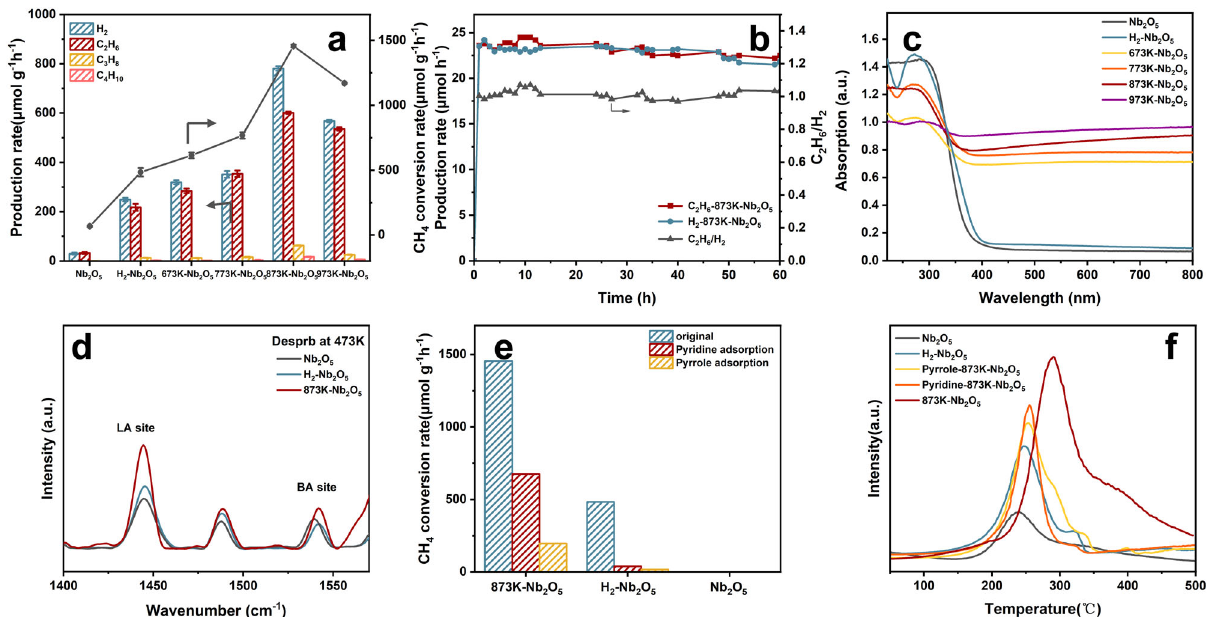
Fig. 2 | Assessment of NOCM activity. a The hydrocarbon products, hydrogen yields, and the methane conversion rate over Nb 2 O 5 . Reaction condition: Batch quartz reactor, 5mg catalyst, 45mL methane, irradiated under 300W Xe lamp for 4h. Shown are mean valuesand error bars are standard deviation. b The long-time photocatalyticNOCMreactionsover873K-Nb 2 O 5 inthe fl ow-typereactor.Reaction